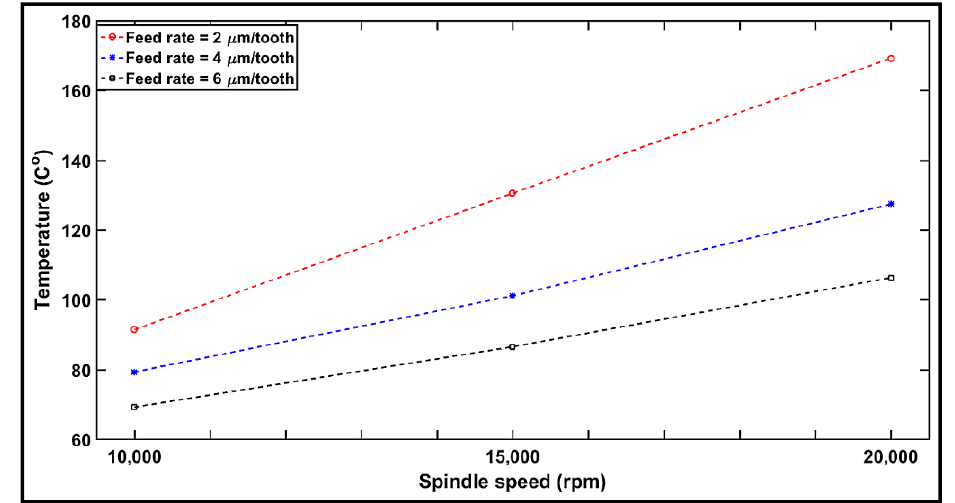
Figure 5. Variation in cutting temperature as a function of spindle speed and feed rate.